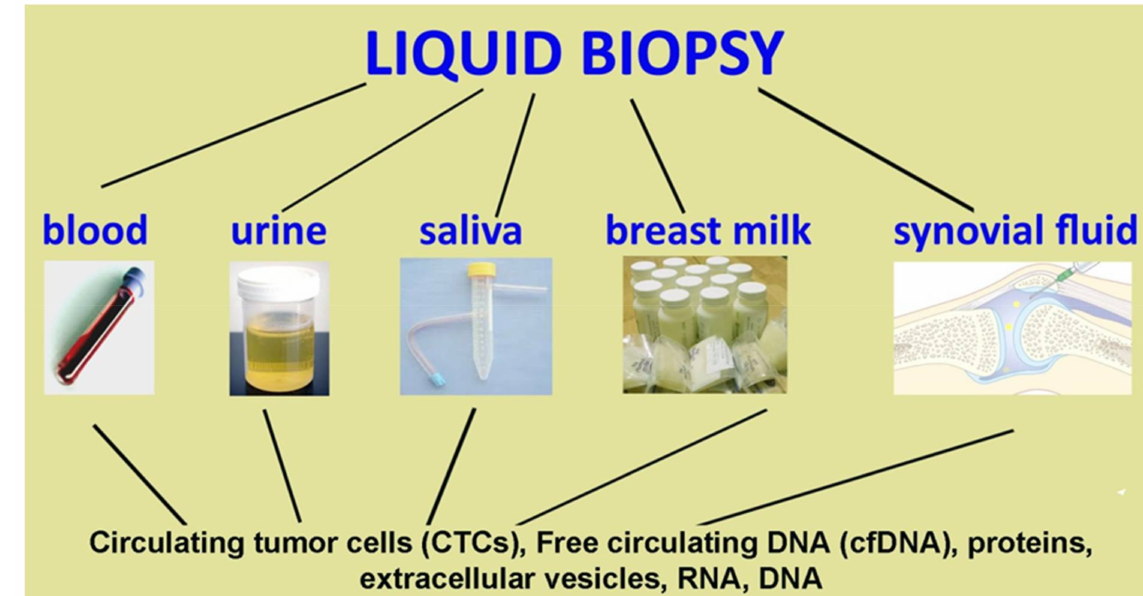
Figure 3. Scheme of different biologic fluids and elements contained in these fluids; in the figures it is possible to see the presence of the same elements in all body